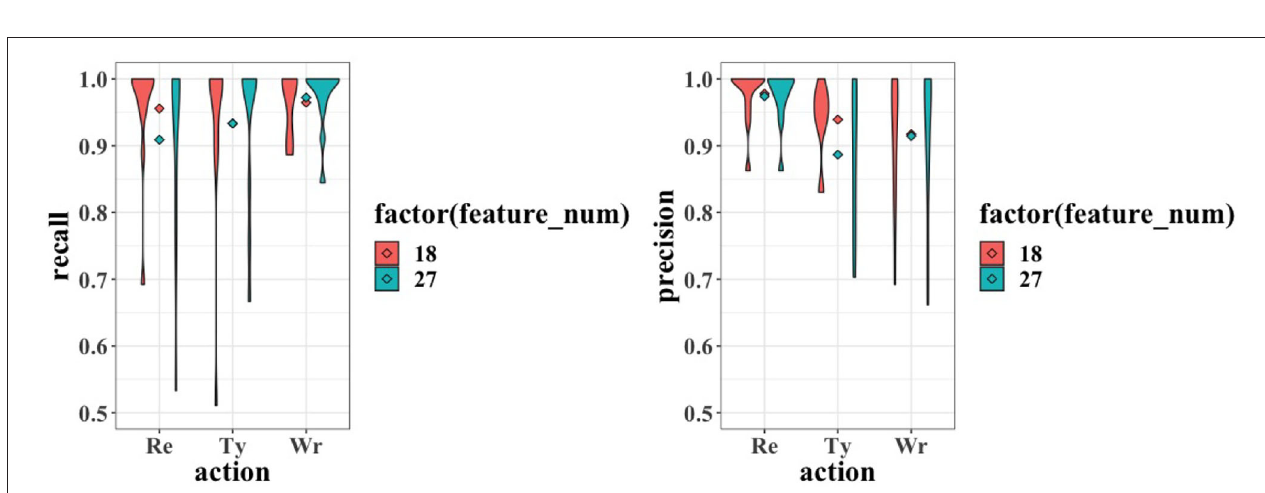
FIGURE 7 | Confusion matrices of the CNN(2) model by using the two combination of features in the LOO validation. The correspondence is indicated by the title of the matrices.